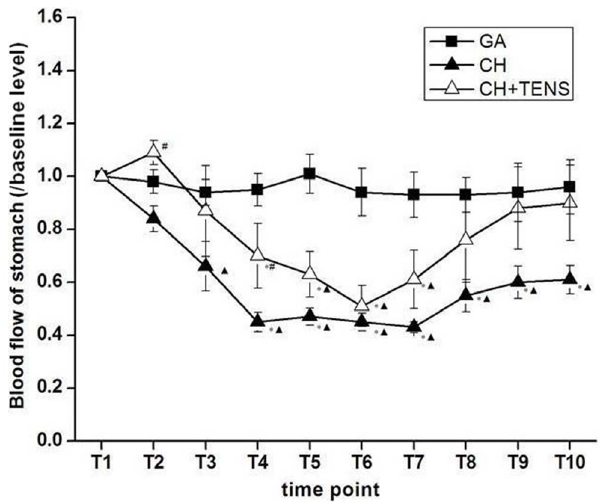
Figure 6. Blood flow to the cerebral cortex during controlled hypotension (CH). During the maintenance stage (T 3 –T 6 ), the cerebral cortical blood flow in the CH and CH + TENS (2/100 Hz, bidirectional rectangle pulse with 0.6/0.2 ms pulse width,3–5 mA for more than 90 min) groups decreased significantly compared with their respective baselines and the general anesthesia (GA) group. Soon after stopping the SNP infusion (T 7 –T 10 ), cerebral cortical blood flow in the two groups administered CH gradually returned to baseline levels. Given these findings, TENS appeared to have no effect on the perfusion of the cerebral cortex. Data are presented as mean 6 standard error of the mean. * P , 0.05 vs. general anesthesia (GA) group, m P , 0.05 vs. basal level, n=6 per